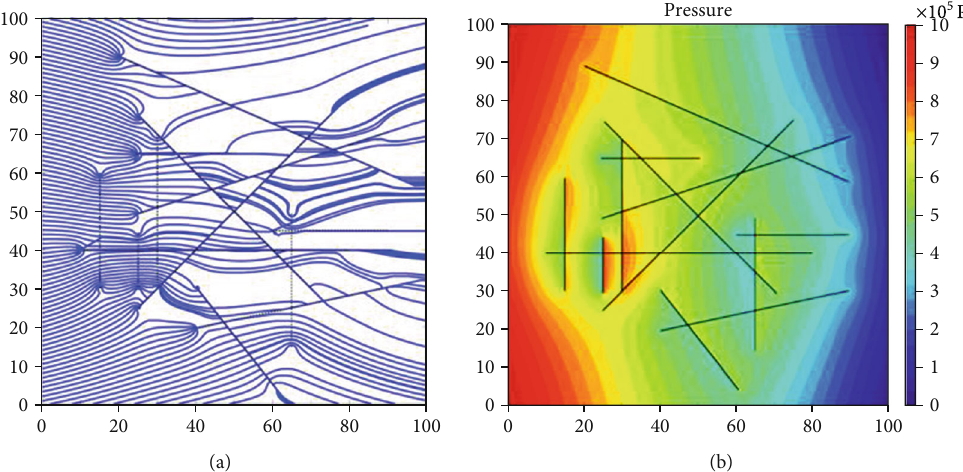
Figure 13: a) Particle paths for the model in Figure 12 using CAM based on the inputs from Table 5. (b) Pressure contours (in Pa) for the model in (a) from